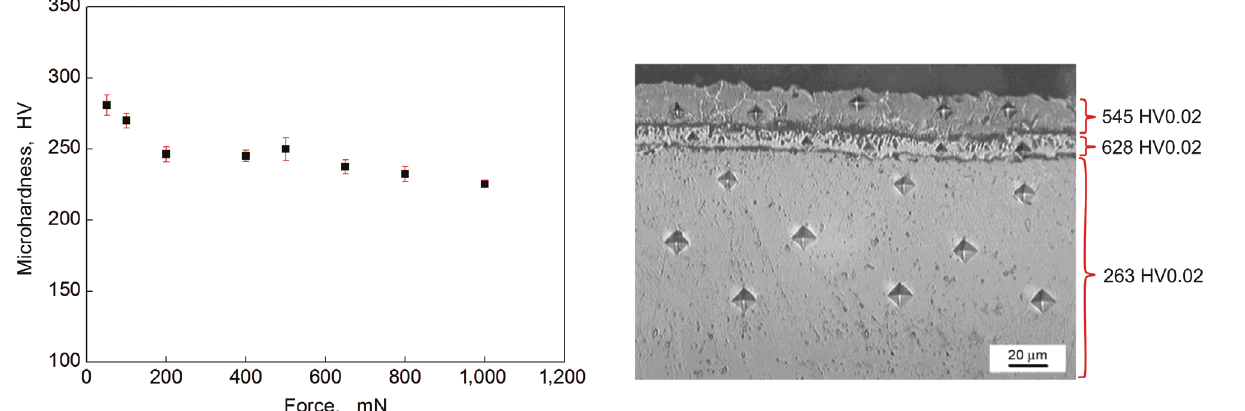
Figure 9: Visible Vickers indents in the cross section of the sample material and in particular zones of the aluminide coating ( T ¼ 1,050°C, t ¼ 8 h, p ¼ 150